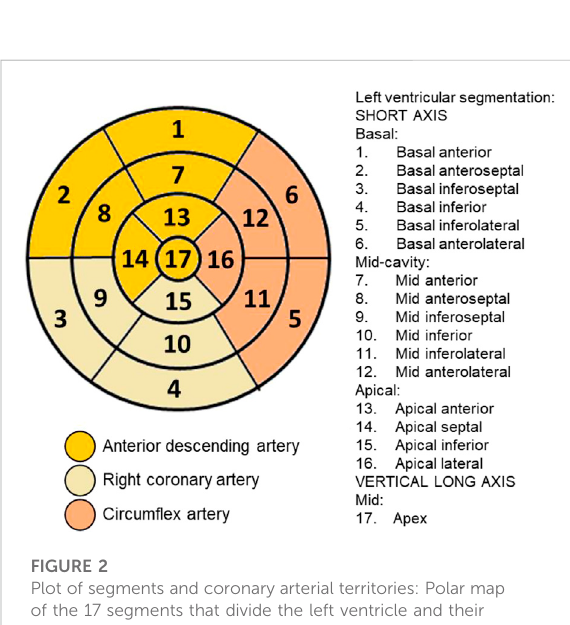
FIGURE 2 Plot of segments and coronary arterial territories: Polar map of the 17 segments that divide the left ventricle and their correspondence with the coronary territories for use in cardiac imaging techniques, de fi ned by the American Heart